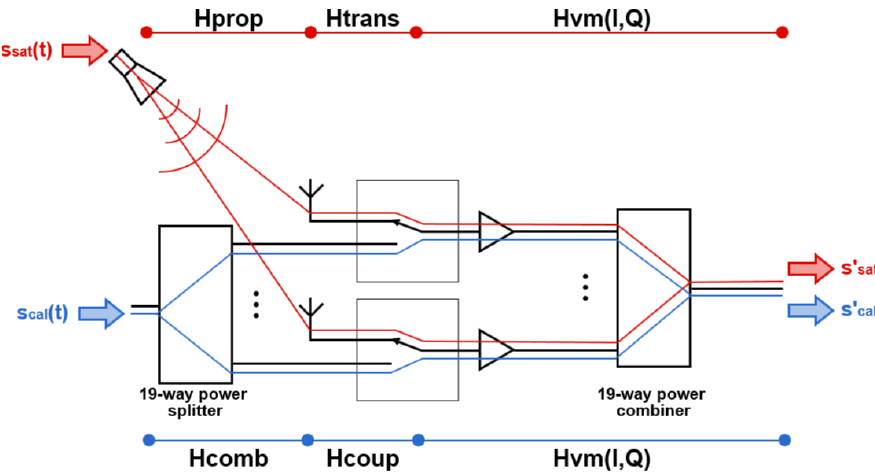
Figure 13. Received and calibration signal’s paths to the receiver in one of the bands and